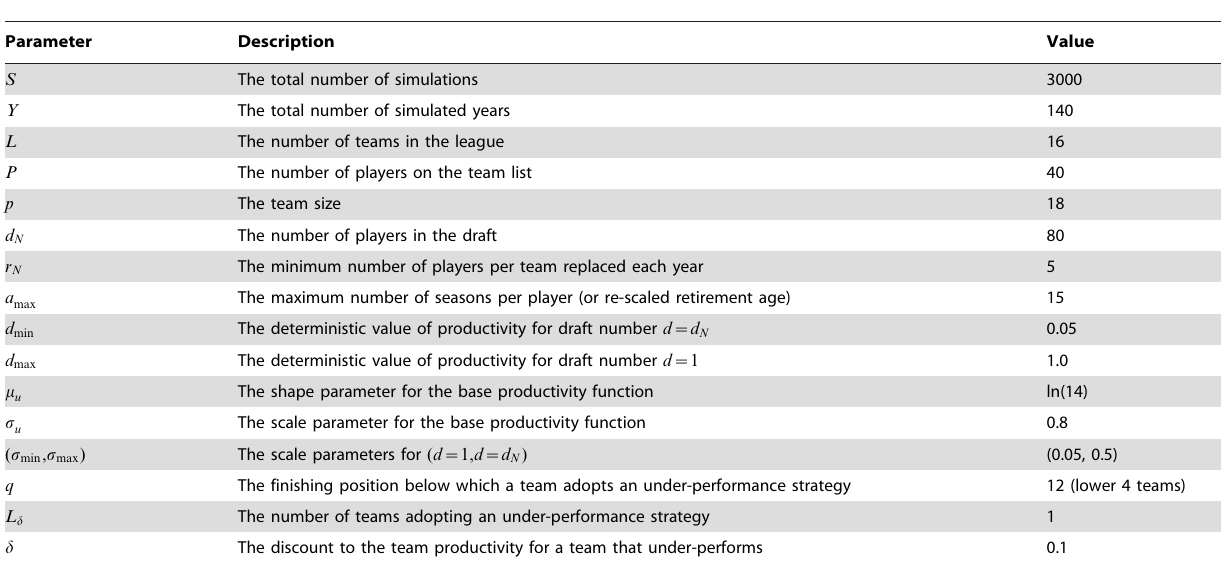
Table 2. The base-case parameter set based upon an AFL-like competition.